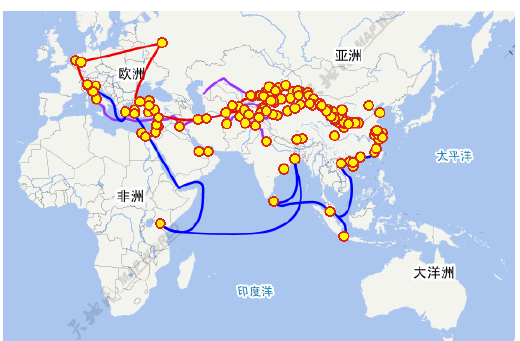
Figure 8. Silk Road and Ancient